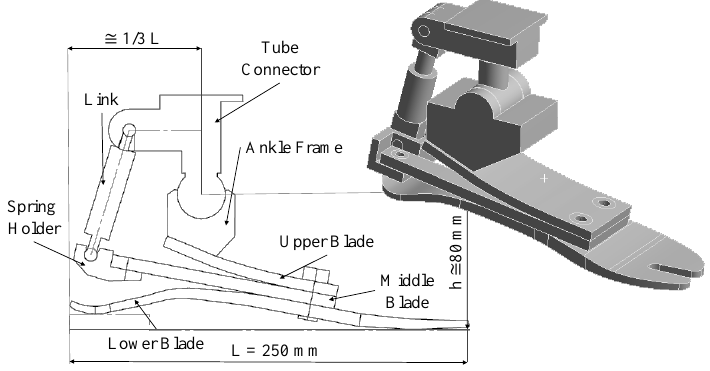
Figure 1. Dimensions and simplified 3D CAD of MyFlex- γ .